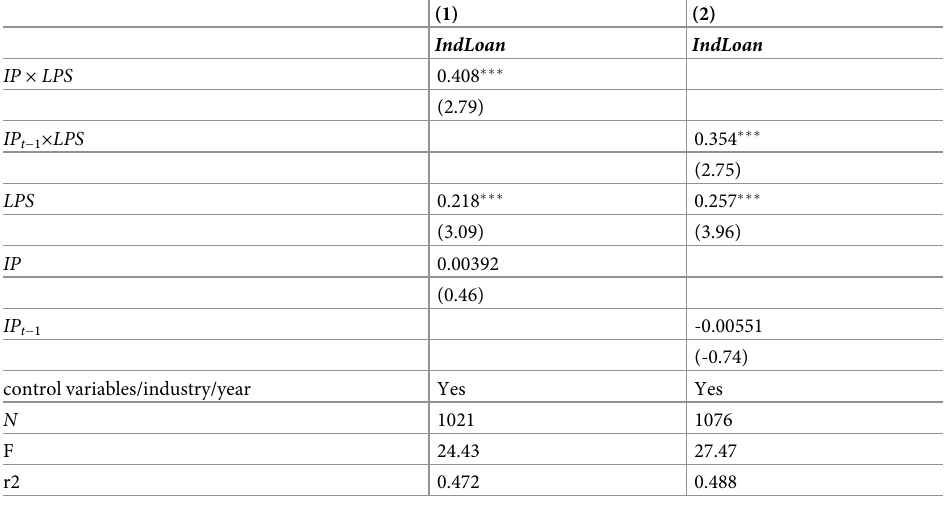
This table reports the results of OLS regression analyzing the moderating effect of local industrial policies considering the timeliness of industrial policies. Columns 1 and 2 use IndLoan as the dependent variable. Variables are defined in Table A1 in S1 Appendix. The sample period is from 2007 to 2020. In parentheses are t-statistics. ��� , �� , � indicate statistical significance at the 1%, 5%, and 10% level,